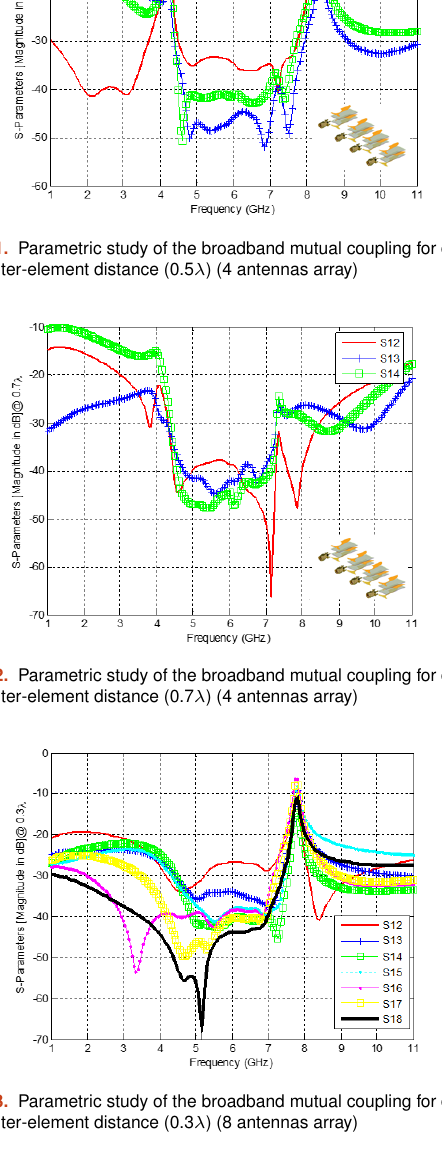
coupling levels between adjacent antipodal Vivaldi antenna.